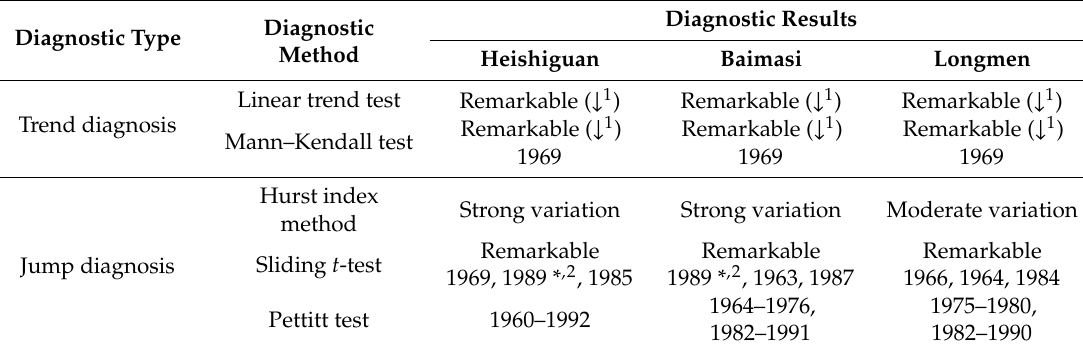
Table 2. Variation points and degree.